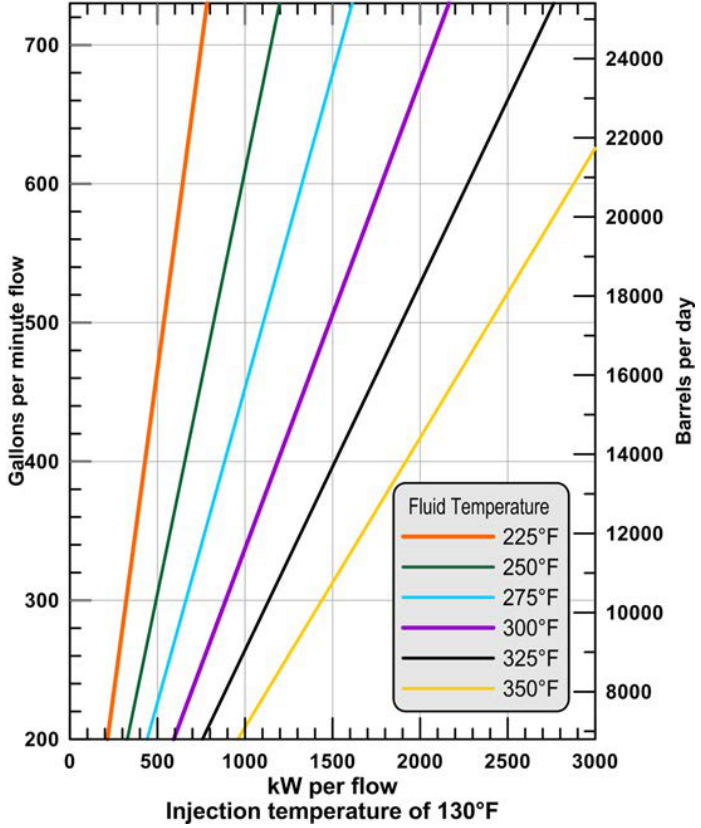
Figure 2. Southern Methodist University Geothermal Laboratory comparison of fluid flow rates and temperatures versus the potential output from a generic geothermal power plant, based on Figure 7.3 in Tester et al. (2006). 1000 kilowatts (kW) is equal to producing 24,000 kilowatt-hours in one day (kWh/day). The 2020 average daily rate for a Texas home is 37.3 kWh/day (EIA 2020). New methods for extracting geothermal resources are being developed that do not use produced fluids and/or include changes in surface technology that this graphic may not